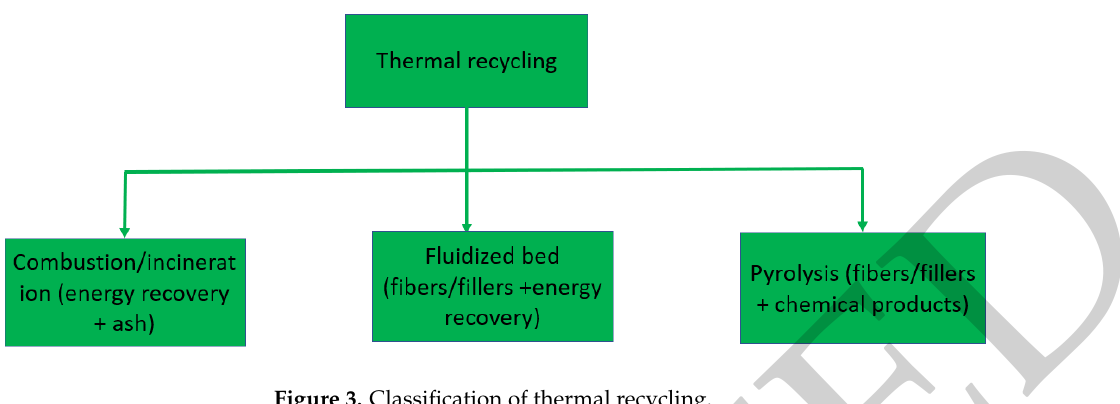
Figure 3. Classification of thermal recycling.